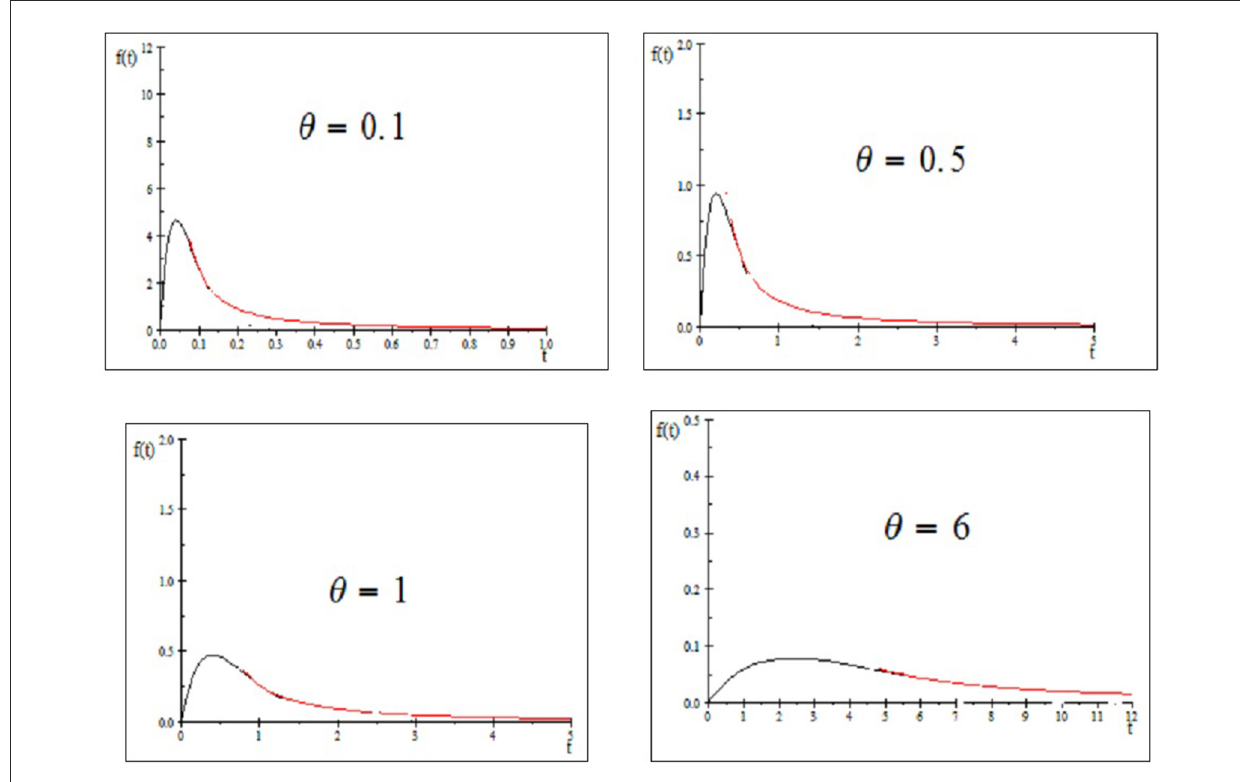
FIGURE1 The plots of PDF for some parameter value of θ